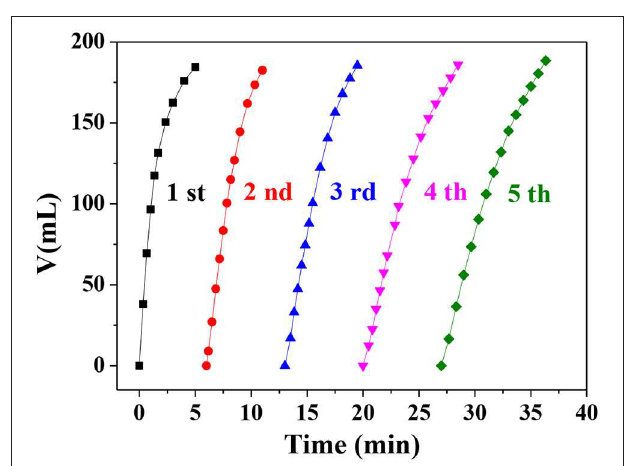
line is generated. According to the Arrhenius equation,